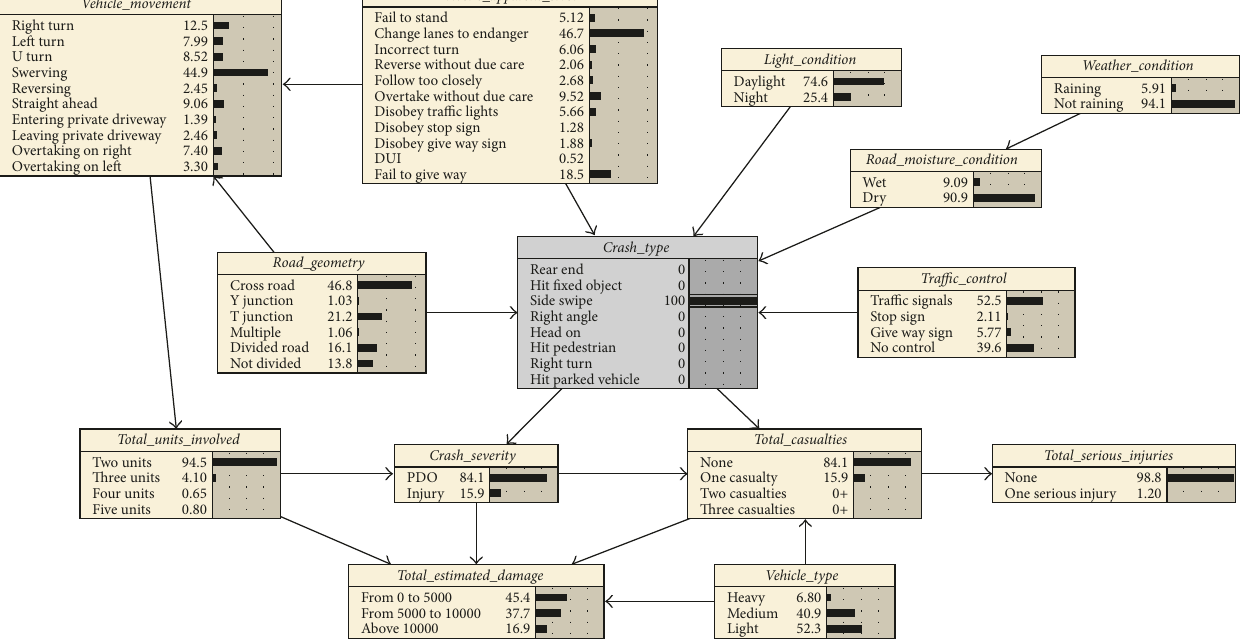
Figure 11: The posterior probability when the evidence variable is “side